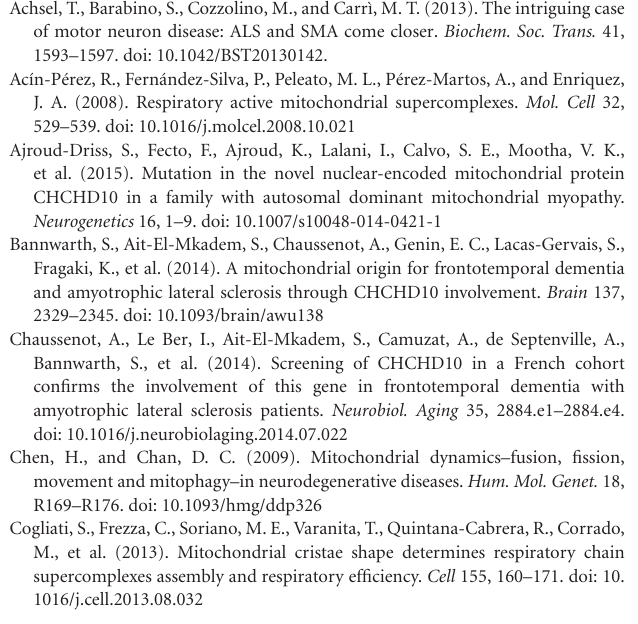
FIGURE 1 | Structural features of CHCHD10 . Four exons of the human CHCHD10 gene encode for a 142 aa mature protein. A coiled helix coiled helix domain (CHCH) is present in the C-terminal half of the polypeptide. A twin CX9C domain, which is targeted by the Mia40/Erv1 mechanism of oxidative import of mitochondrial proteins, is also present. A putative